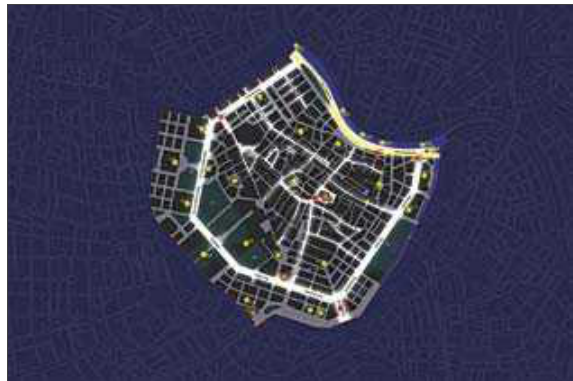
Fig. 3. Master Lighting Plan of Vienna centre